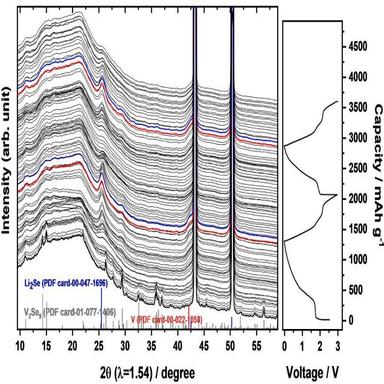
In situ XRD spectra of V2Se9 during the first two cycles alongside the voltage profile.